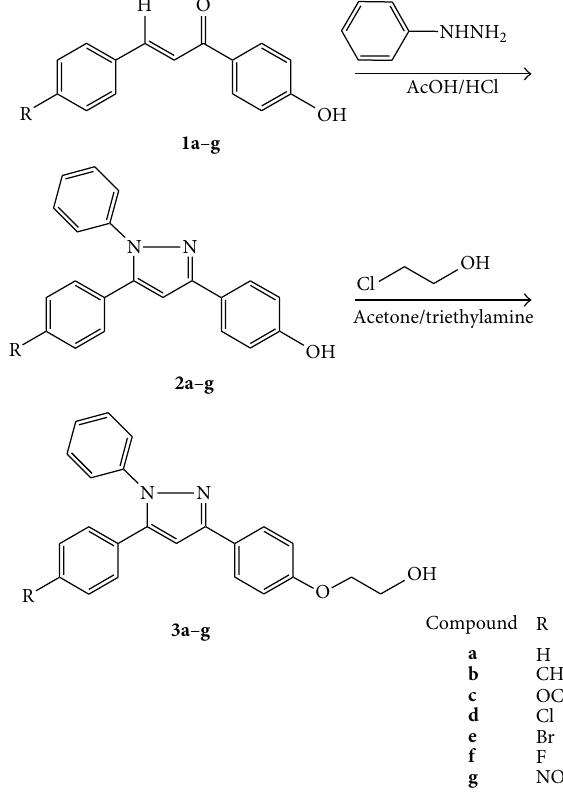
S 1: Synthesis of 1-Phenyl-3-(4-(2-ethanoloxy) phenyl)-5- aryl-1 H